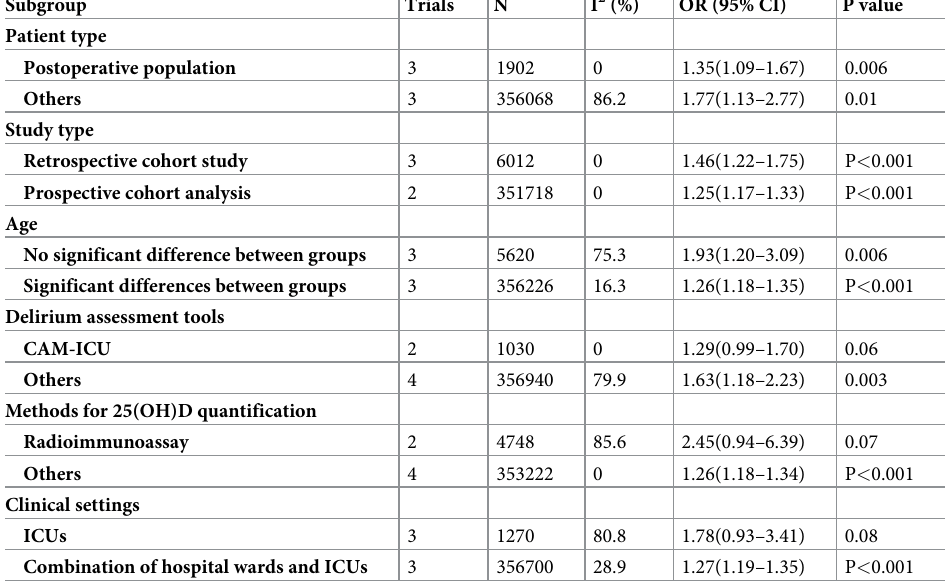
Table 3. Subgroup analysis of